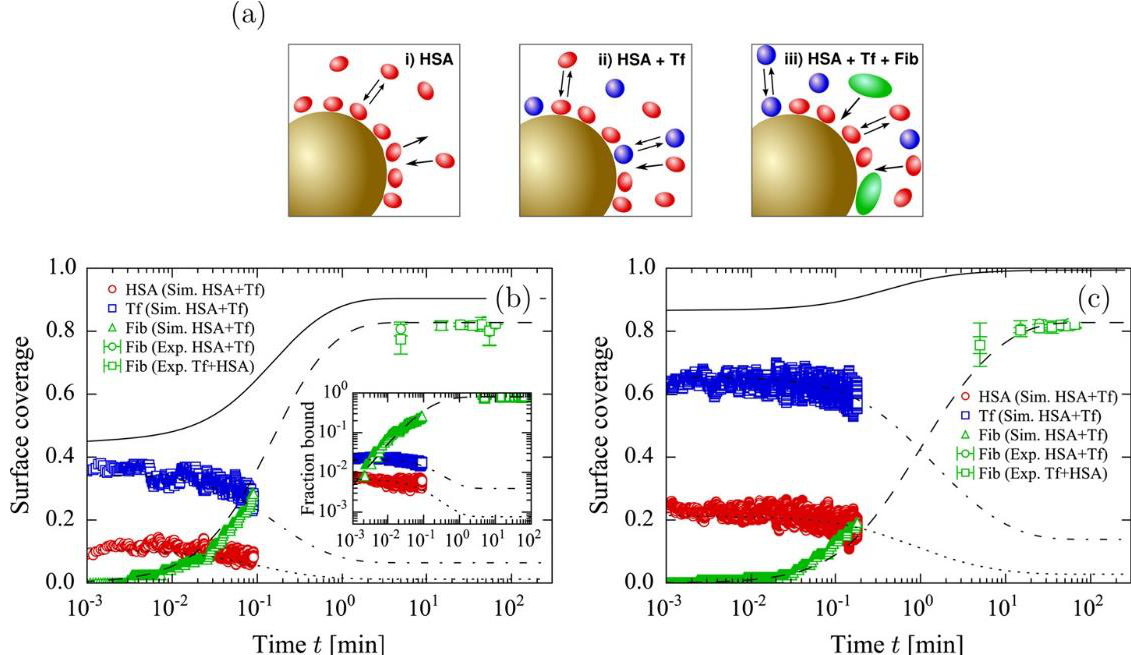
Figure 8. Adsorption of FG (green) on silica NPs precoated with HSA (red) first and TF (blue) next. ( a ) Schematic illustration of three steps for the adsorption process. ( b ) Surface coverage of HSA, TF, and FG adsorbed onto silica NPs as a function of time. ( c ) Surface coverage of HSA, TF, and FG adsorbed onto silica NPs at high protein concentrations. Reproduced with permission from [60], American Chemical Society, 2016.